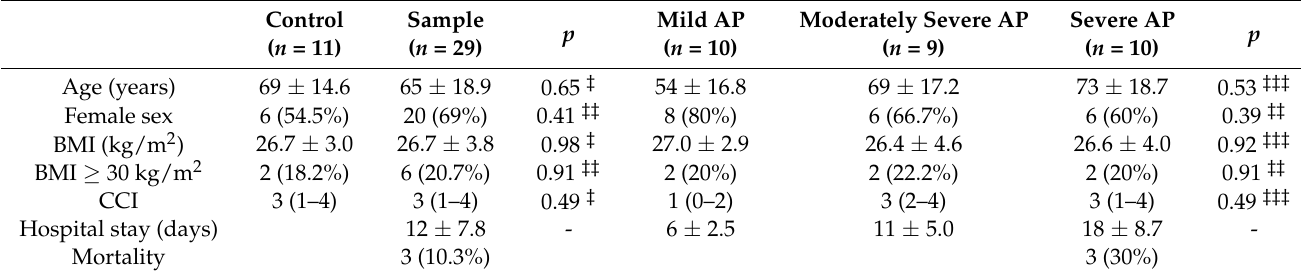
Table 1. Baseline characteristics of healthy controls and biliary AP patients included in the study. ( ‡ Mann–Whitney test; ‡‡ Chi-squared test; ‡‡‡ Kruskal–Wallis